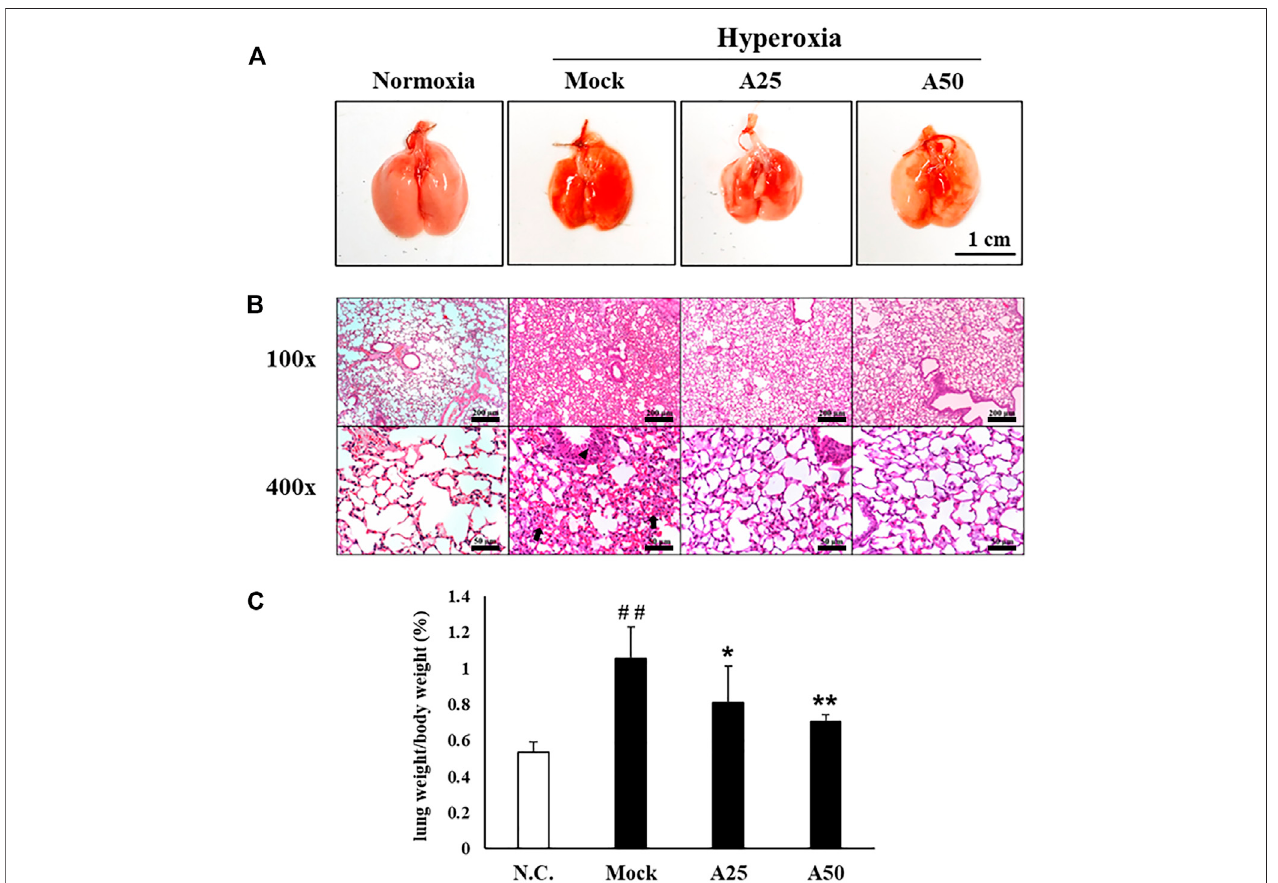
FIGURE2| Therapeuticef fi cacyofaspirin against lung in fl ammationinmice (A) Gross appearance ofthelungs from NF- κ B-luciferase +/+ transgenic mice exposed to hyperoxia. Scale bar: 1 cm (B) Histological changes in the lungs of NF- κ B-luciferase +/+ transgenic mice exposed to hyperoxia. Scale bars for the upper panel represent200 µmandlowerpanelrepresent50 µm (C) Lung-to-bodyweightratioofNF- κ B-luciferase +/+ transgenicmiceexposedtohyperoxia.Thevaluesarereported as the means ± SEM ( n (cid:1) 6 mice per group). ## p < 0.01 compared with the N.C. group; * p < 0.05 and ** p < 0.01 compared with the Mock group. N.C, treatment with PBS at 0, 24, and 48 h and exposure to normoxia; Mock, treatment with PBS at 0, 24, and 48 h and exposure to hyperoxia for 72 h; A25, treatment with 25 μ g/g aspirinat0,24,and48 handexposuretohyperoxiafor72 h;A50,treatmentwith50 μ g/gaspirinat0,24,and48 handexposuretohyperoxiafor72 h.Arrow:redblood cells in the intra-alveolar space, consistent with hemorrhage. Triangle: intrapulmonary hemorrhage with some histiocyte aggregation.